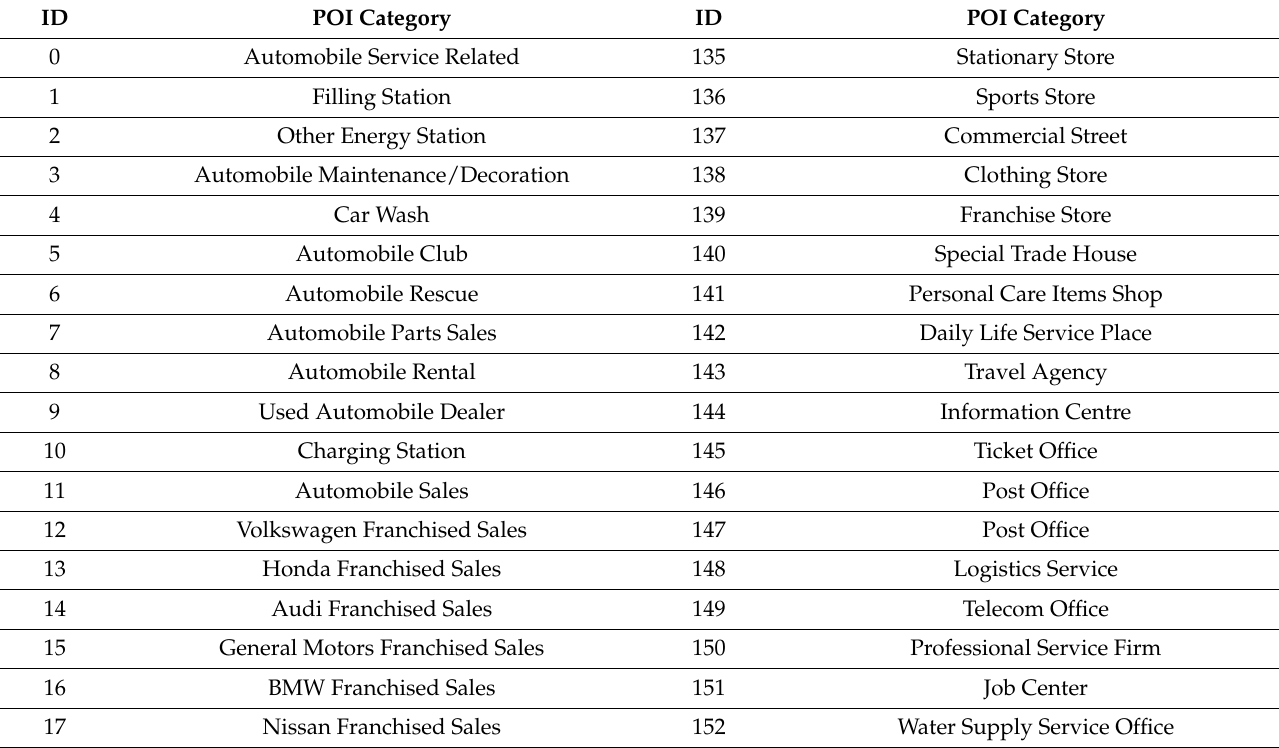
Table A1. POI categories used in this